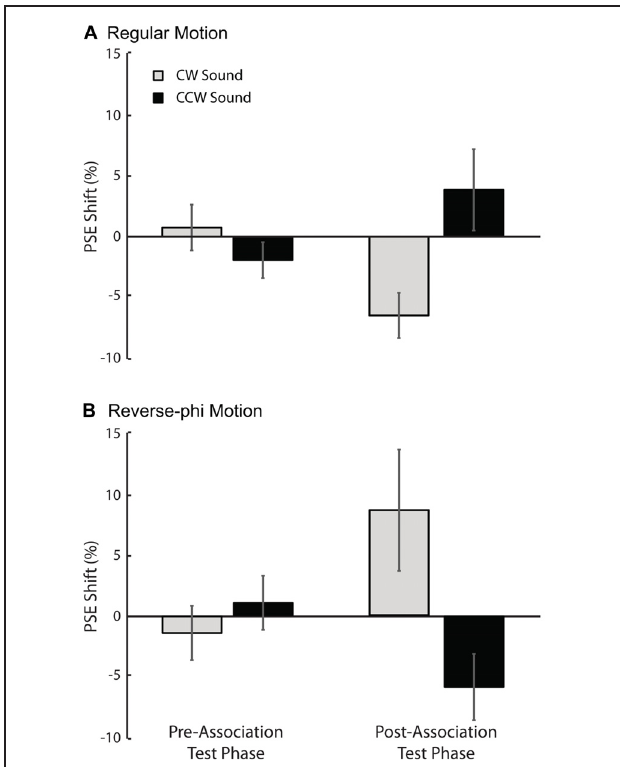
FIGURE 3 | Results of Experiment 1 (regular motion used in the association phase). The averaged PSE shifts (in units of motion coherence level) of all observers as a function of test phase. (A) Pre-association and post-association data for regular motion. (B) Pre-association and post-association data for reverse-phi motion. The gray and black bars represent CW and CCW sound conditions, respectively. Error bars indicate +